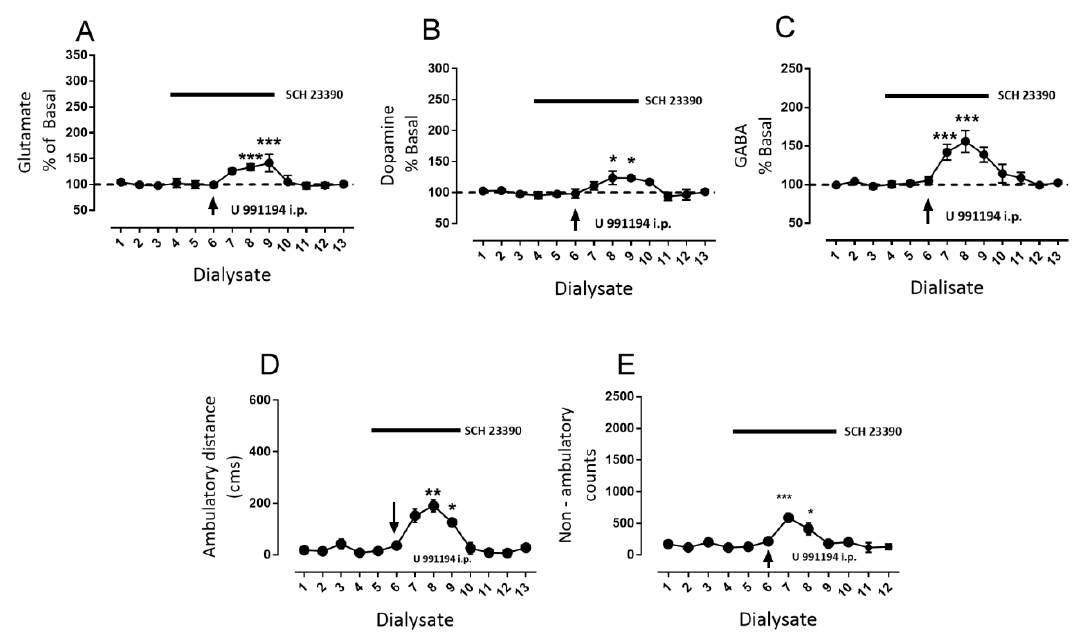
Figure 7. Intra-nigral blockade of D1R diminishes increments in the neurotransmitter and locomotor activity elicited by D3R systemic blockade. ( A ) the percentage is shown of the change of interstitial nigral glutamate in dialysate X with respect to dialysate 1 (baseline), with the bar indicating the intra-nigral perfusion of D1R antagonist SCH 23,390 (1 µ M), and the arrow indicating the injection of a single dose of D3R selective antagonist U 99194A (25 mg / kg i.p.). ( B , C ) are the same as ( A ), but with dopamine and GABA, respectively. In ( D , E ), the change is shown in ambulatory distance in cm, and non-ambulatory activity in light-beam counts in the 20 min period during which the respective dialysate was collected. * p < 0.05, ** p < 0.01, and *** p < 0.001 with respect to dialysate three (before antagonist injection), two-way ANOVA following by Tukey, n = 6 rats.